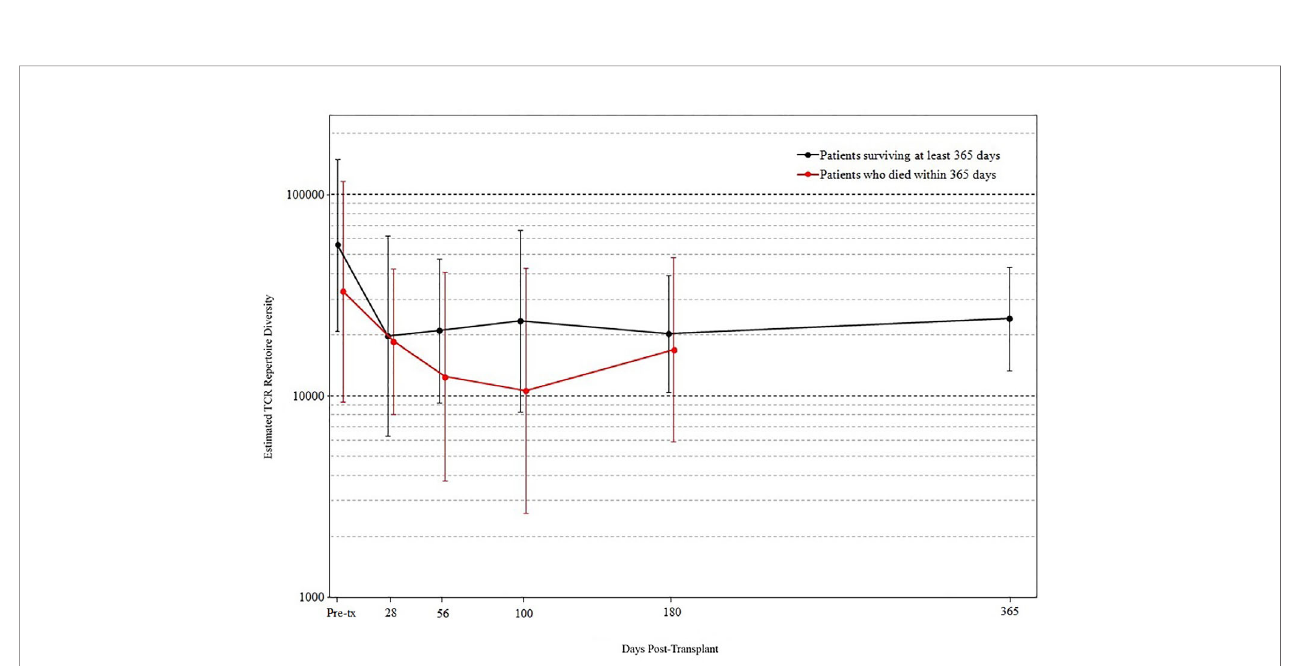
FIGURE 4 | T cell receptor (TCR) repertoire comparison by outcome. Peripheral blood samples were taken from each cord blood transplantation (CBT) patient before transplant and fi ve times after transplant. TCR repertoire size for each sample was estimated using high-throughput sequencing of TCR rearrangements. Patients are divided into those who survived through 1-year posttransplant (black) and patients who died within 1 year (red). At each of six time-points (pre-tx, 28, 56, 100, 180, 365 days posttransplant), we report the geometric mean and standard deviation of TCR repertoire size for each group of patients. At day 100, the median TCR repertoire size of patients who died was signi fi cantly lower than that of patients who survived (p = 0.019 by permutation). For the six time-points in order, N = 17, 16, 18, 18, 19, 17 for patients who survived through day 365; N = 15, 14, 11, 10, 8 for patients who died before day 365. At each time-point, all surviving patients with TCR sequencing data are